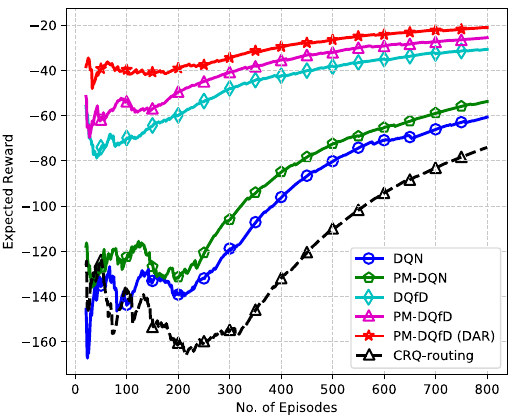
Figure 8. Expected reward versus number of episodes.